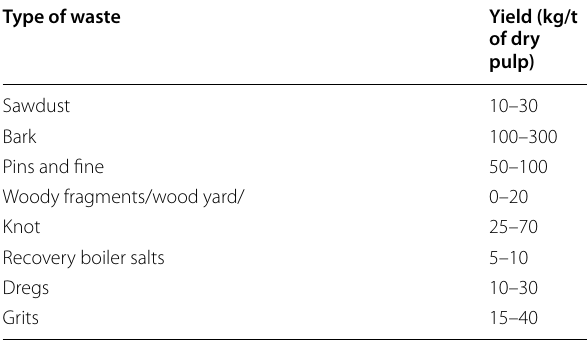
Table 4 Generation of solid waste from kraft mill